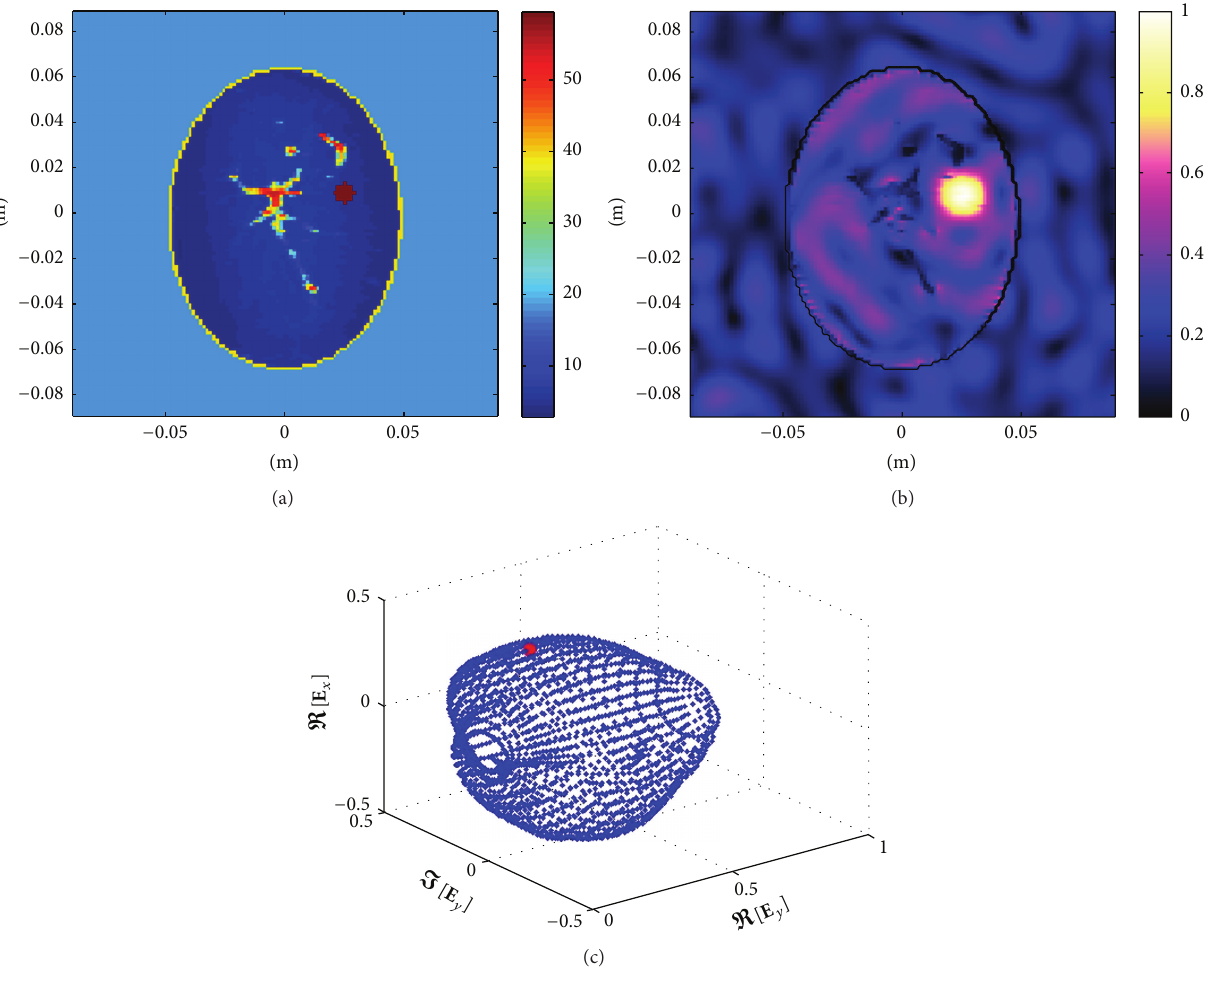
Figure 1: Focusing in a fatty breast phantom (slice 155, ID: 071904) [20, 21]: (a) permittivity profile, (b) intensity of the field | E (𝑟)| focused into thetumor,and(c)polarplotoftheoptimalfieldintensity(i.e., 𝐹( p ) ),asafunctionofallpossiblepolarizations p ofthefieldintothetargetpoint performed by the corresponding optimal excitations set I = [𝐼 1 , 𝐼 2 ,...𝐼 𝑛 ] . The red dot represents the polarization ( p = [0.4148,0.9099𝑒 −𝑗0.53𝜋 ] ) which provides the highest field intensity into the target point | E (𝑟 𝑇 )| for a fixed UB (𝑟)